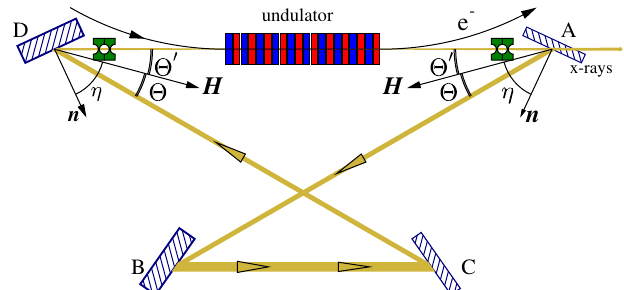
FIG. 6. (Color) Scheme of a four-crystal x-ray optical cavity with asymmetrically cut crystals (the crystal surface normal n makes a nonzero angle (cid:7) with the diffraction vector H ) allowing tailoring angular acceptance and spectral width of Bragg reflec- tions. Note that the angles of incidence (cid:1) and reflection (cid:1) 0 are no longer equal. The scattering geometry for B is the same as for A, while the scattering geometry for C is the same as for